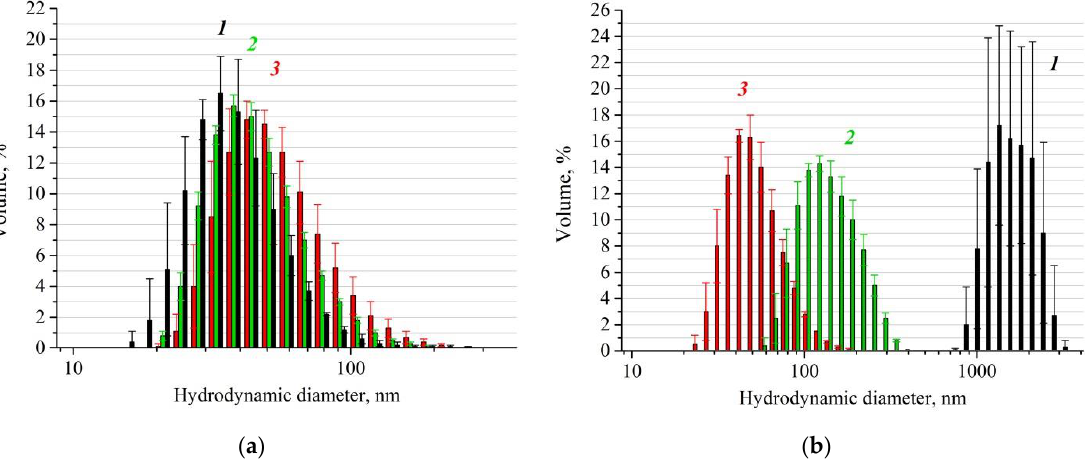
Figure 2. Dynamic light scattering (DLS) size distribution by volume for particles in the control sample “N0” (1, black) and the samples “NH0” (2, green) and “NH1” (3, red): ( a ) After overnight incubation; ( b ) after 30 min of incubation, dilution in 0.05 M phosphate buffer pH 6.3 followed by IgG addition and overnight incubation. C IgG /C IONPs = 0.6 [mg/mg].